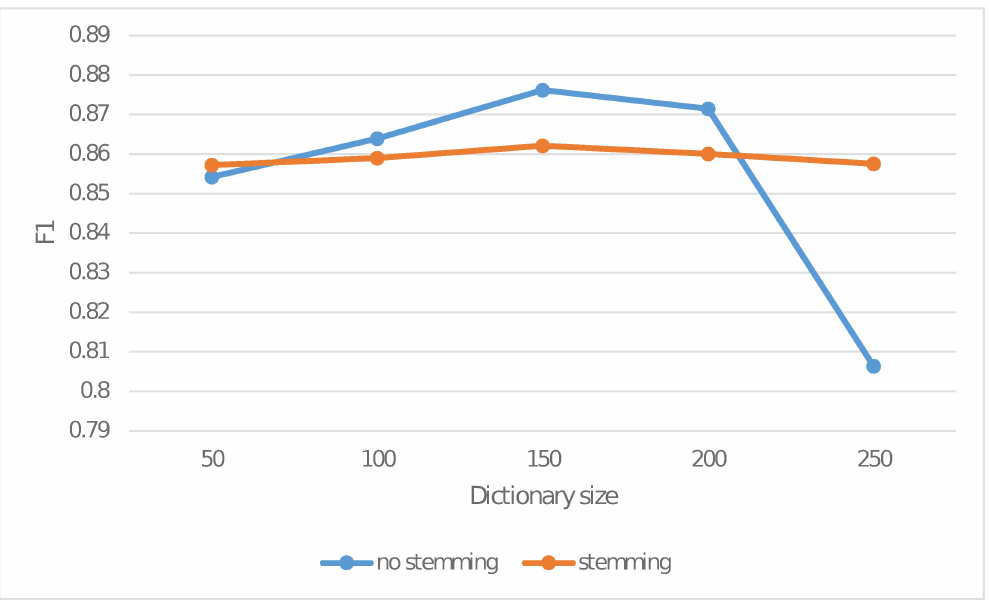
Fig 5. F1 measurewith and without